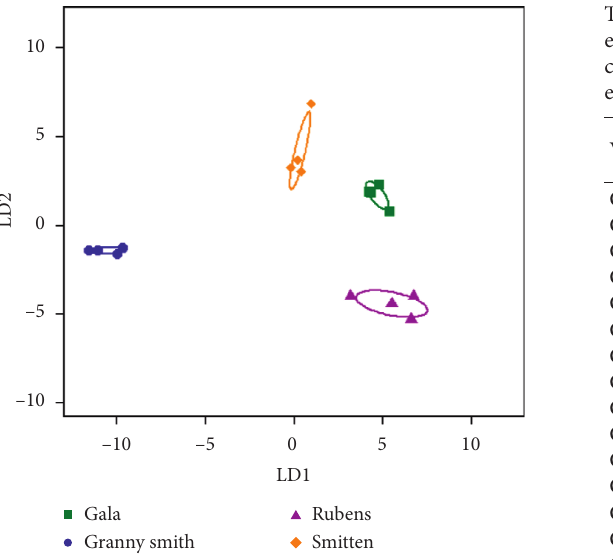
Figure 3: Canonical analysis of principal coordinates based on top 15 VOCs ranked by the mean decrease in classification accuracy: a CAP model was produced from apple samples of four cultivars. The plot uses the first two linear discriminants (LD); each ellipses represents the 95% confidence interval. Percentage of correct classification of 100% ( P < 0 . 001, n � 4). LD1 vs. LD2 accounted for 100% of the total variation within data.